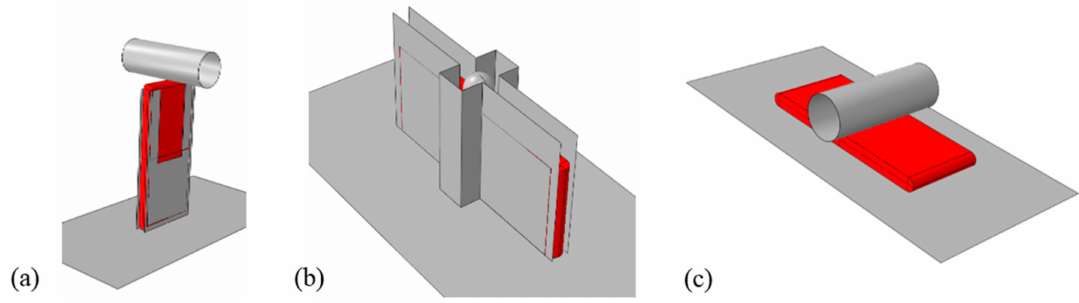
Figure 5. Models of three loading cases: ( a ) X direction; ( b ) Y direction; ( c ) Z direction. (cid:0) (cid:1) ε ij The hardening curves σ ij introduced in Section 2 are the core part of the model